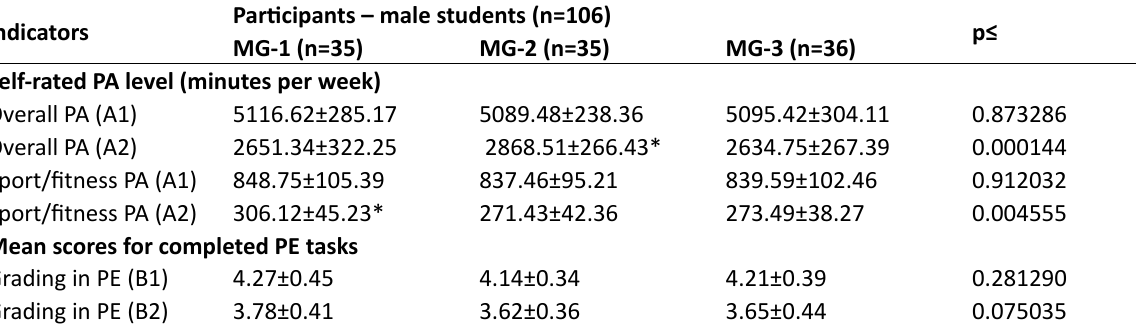
Table 1. Mean PA rates and grading in PE pre - and post-cancellation of face - to - face PE classes for male participants. Indicators